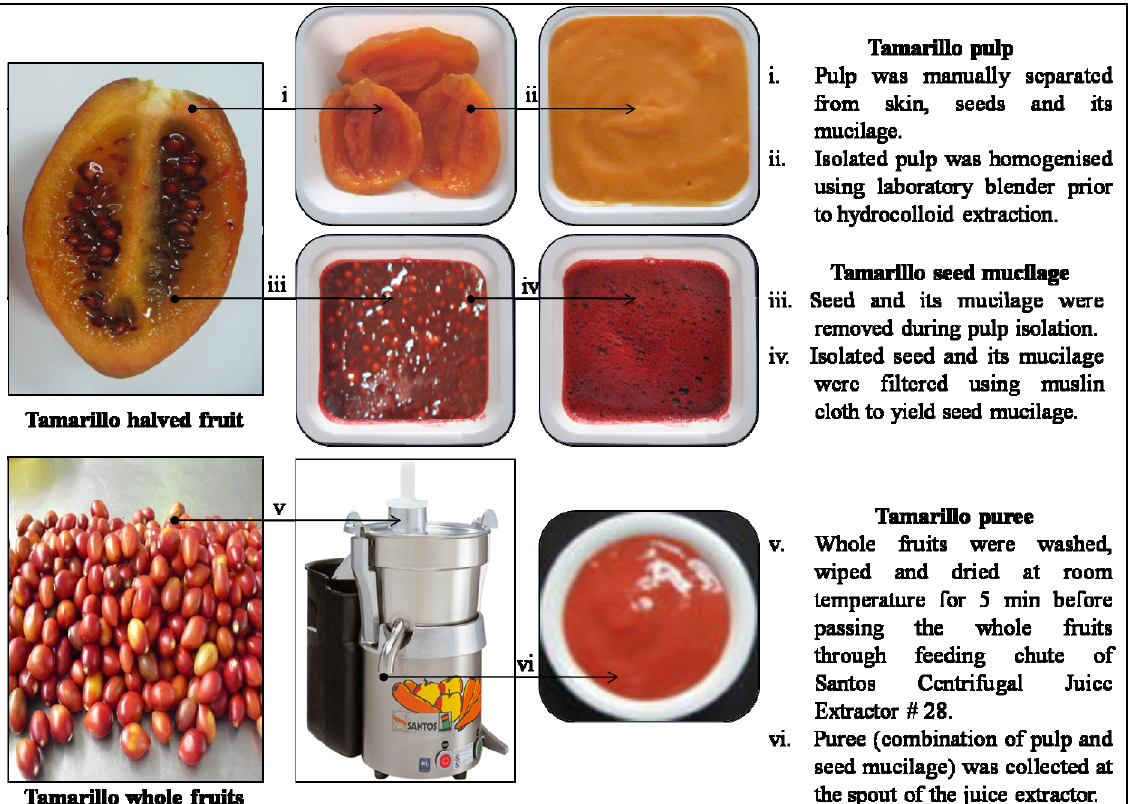
Figure 6. Preparation of pulp, seed mucilage and puree fractions from fresh Tamarillo